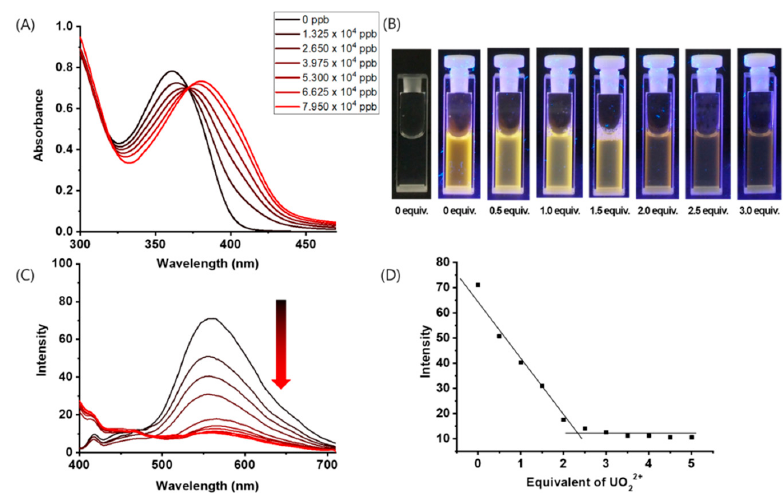
Figure 2. ( A ) UV–vis spectra of compound 1 (2.65 × 10 4 ppb) in DMSO/H 2 O (1:99 v/v ) containing various amounts of UO 22+ . ( B ) Photographed cuvettes from ( A ) under UV light irradiation. ( C ) Fluorescence spectra of compound 1 (2.65 × 10 4 ppb) in DMSO/H 2 O (1:99 v/v ) containing various amounts of UO 22+ (0–5 equivalents). ( D ) Plot of fluorescence intensity of ( C ) vs. amount of UO 22+ .